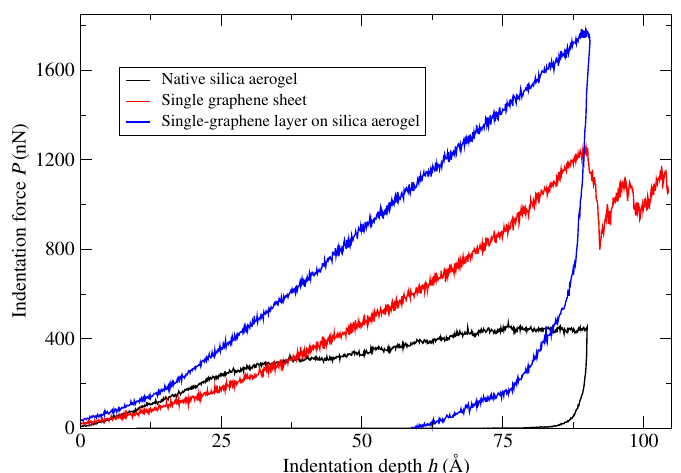
Figure 4. Comparison of indentation force versus depth curves of native silica aerogel, graphene sheet, and a 1G-SiO 2